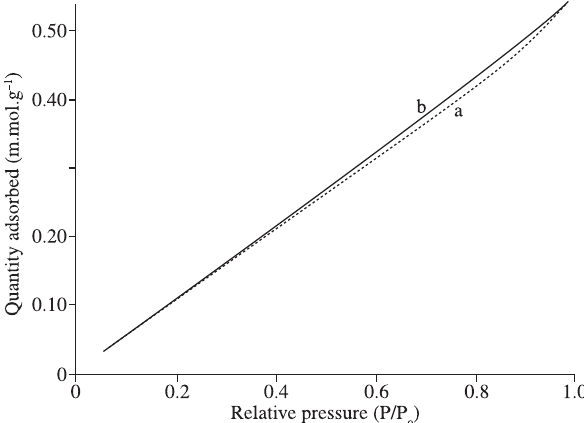
Figure 4. Nitrogen adsorption isotherm curves of mesoporous Mn – organo- phosphate molecular